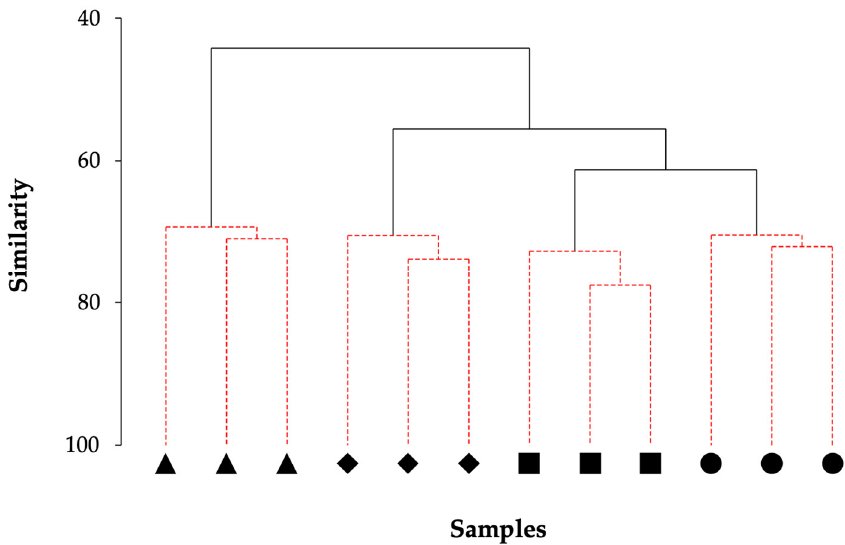
Figure 7. Clustering of samples corresponds with respective study site. Dendrogram resulting from hierarchical cluster analysis of samples from Larsen C study sites (based on Bray–Curtis similarities and using group-average linking). Black continuous lines indicate significant clusters, identified by a SIMPROF test, and red dashed lines indicate non-significant clusters. Site LCP1 = diamonds, LCP2 = triangles, LCP3 = circles, and LCP4 = squares.